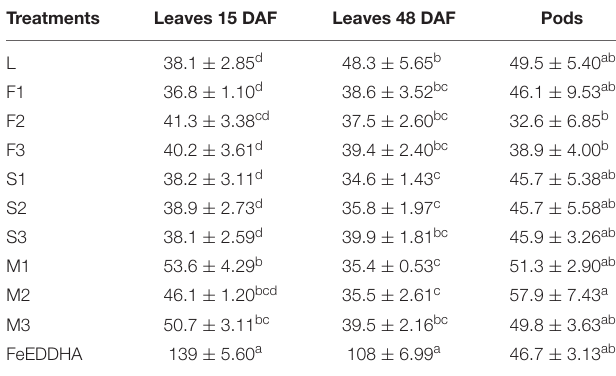
TABLE 5 | Fe Total (mg kg − 1 ) concentration in soybean leaves and pods of plants fertilized with the 57 Fe products F, S, and M in three doses: (1) 35, (2) 75, and (3) soybean pods at 48 DAF.